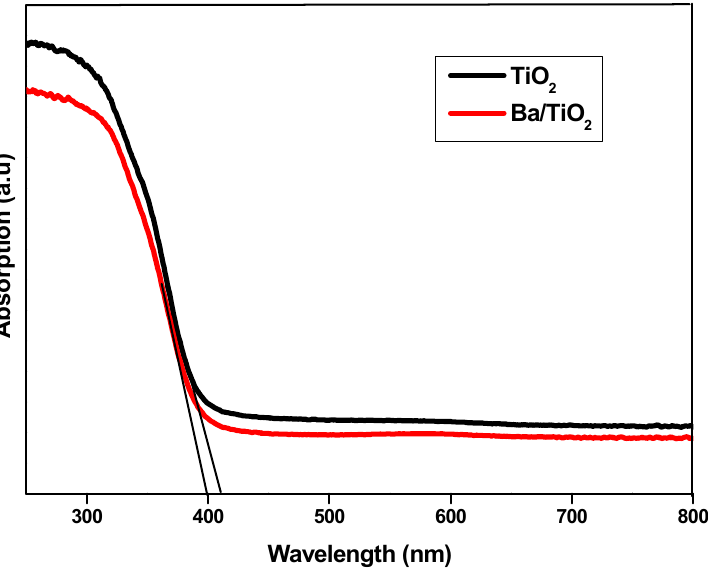
Figure 2. UV-visible spectra of synthesized TiO 2 and Ba/TiO 2 photoanodes.